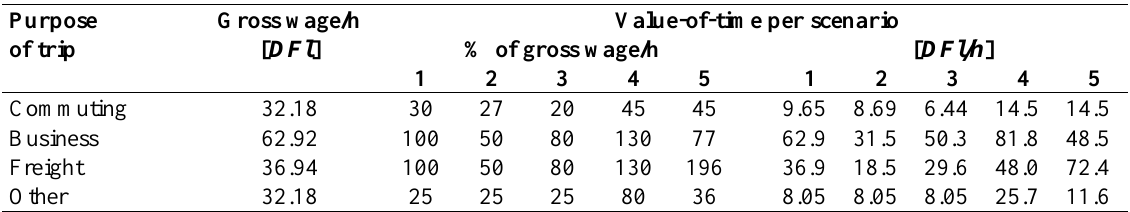
Table 3. Value-of-time of road transport in the Netherlands in 1997 per trip purpose